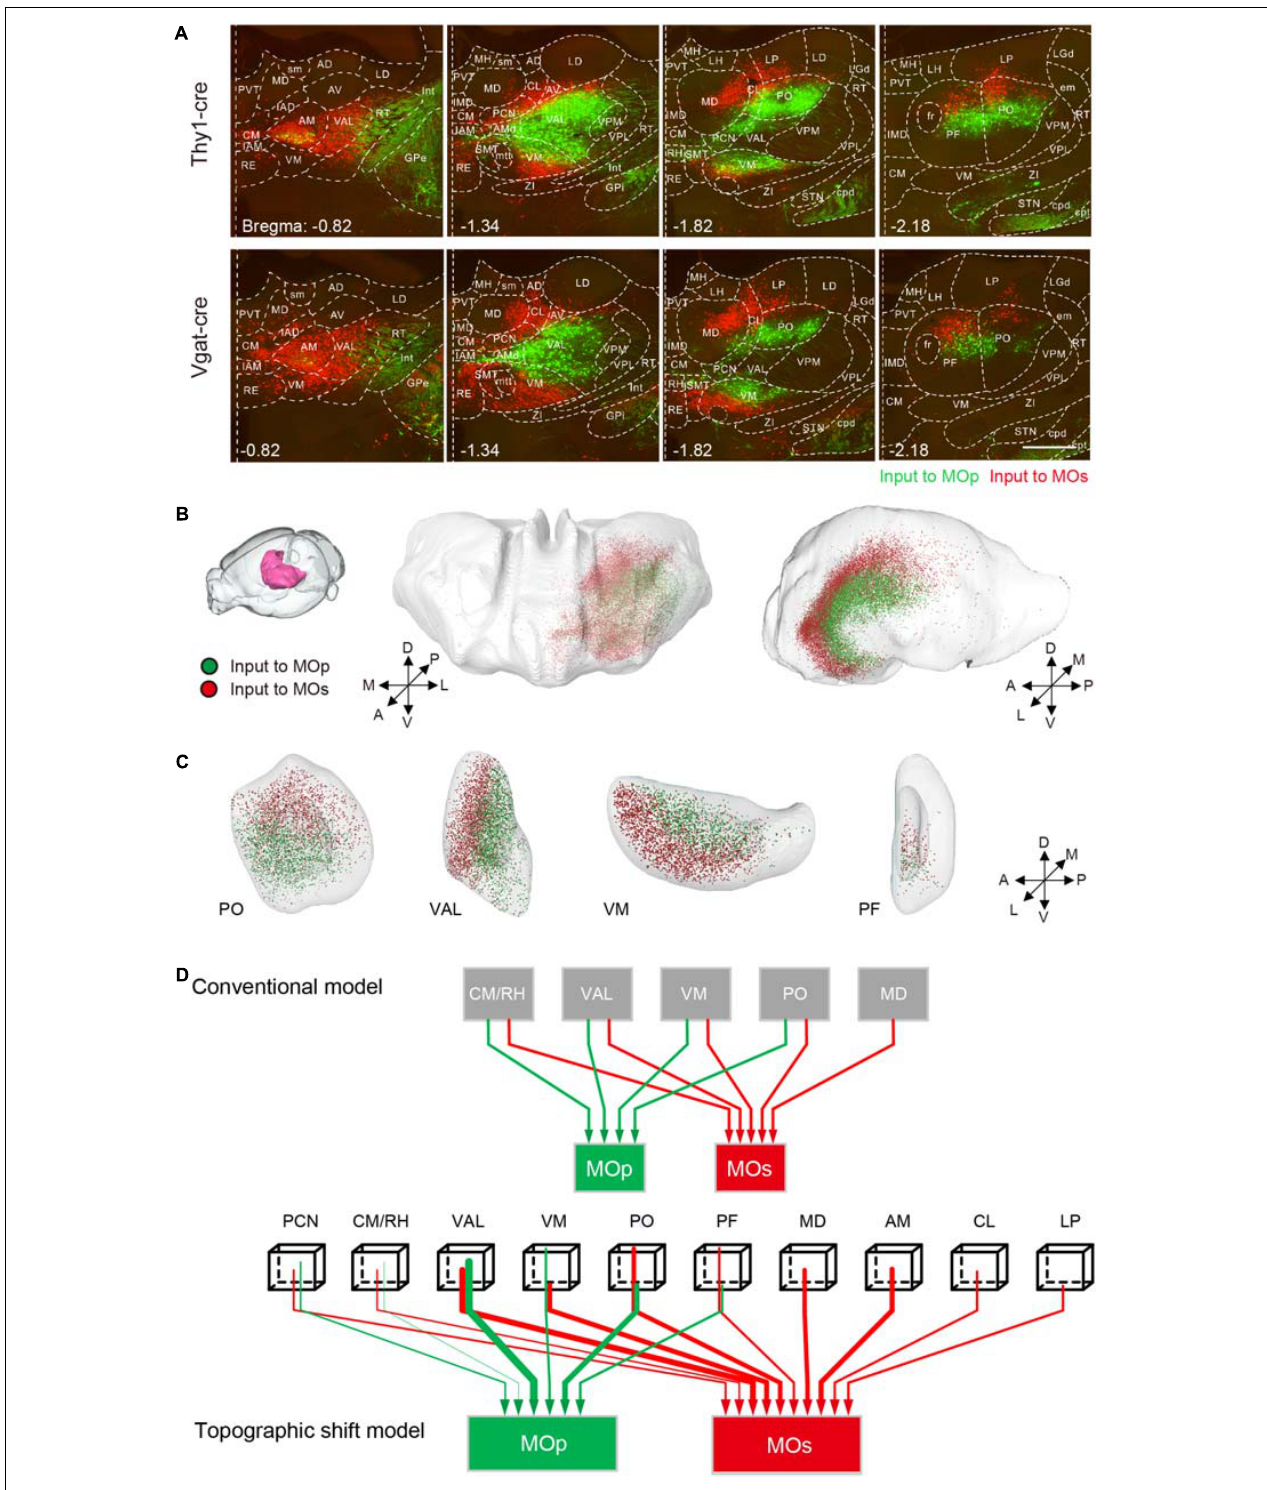
FIGURE 6 | Region-specific thalamic projection to MOp and MOs. (A) Distribution of inputs to the MOp and MOs in the thalamus at different positions. The green signal indicates the neurons projecting to the MOp, while the red signal indicates the neurons projecting to the MOs. Scale bar = 500 µ m. (B) Three-dimensional reconstruction of the thalamic areas. Green dots denote the thalamic neurons projecting to the MOp, while red dots denote the thalamic neurons projecting to the MOs. (C) Three-dimensional reconstruction of the PO, VAL, VM, and PF. (D) Schematic summary of the thalamic-cortical projection pattern. In the topographic shift model, the beginning tips of wirings indicate the relative spatial positions, and the thickness of wirings in both panels indicates the degree of projection.